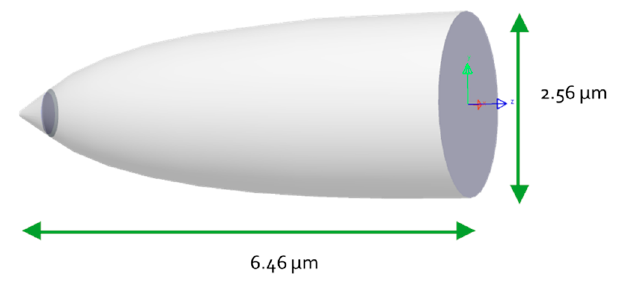
Figure 14. Assembly dimensions obtained with LightTools software.